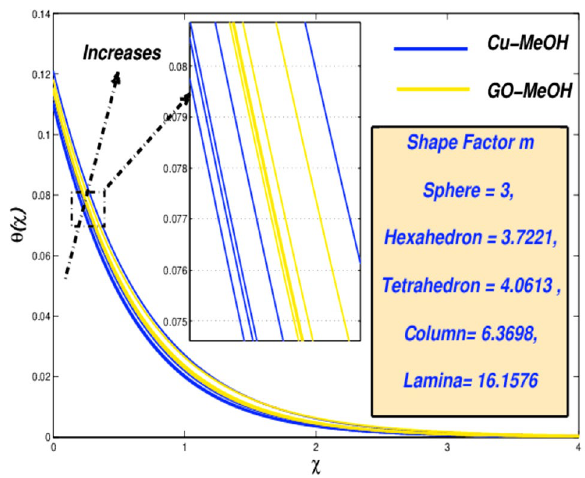
Figure 24. Temperature variation versus m .